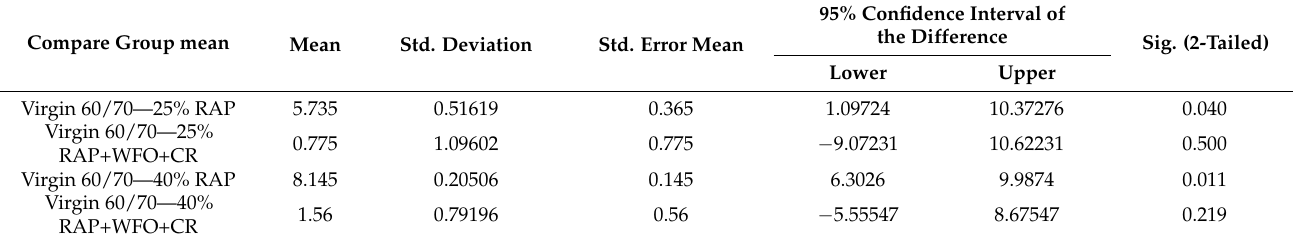
Table 13. Comparison of significant difference of group means for the δ ◦ at different